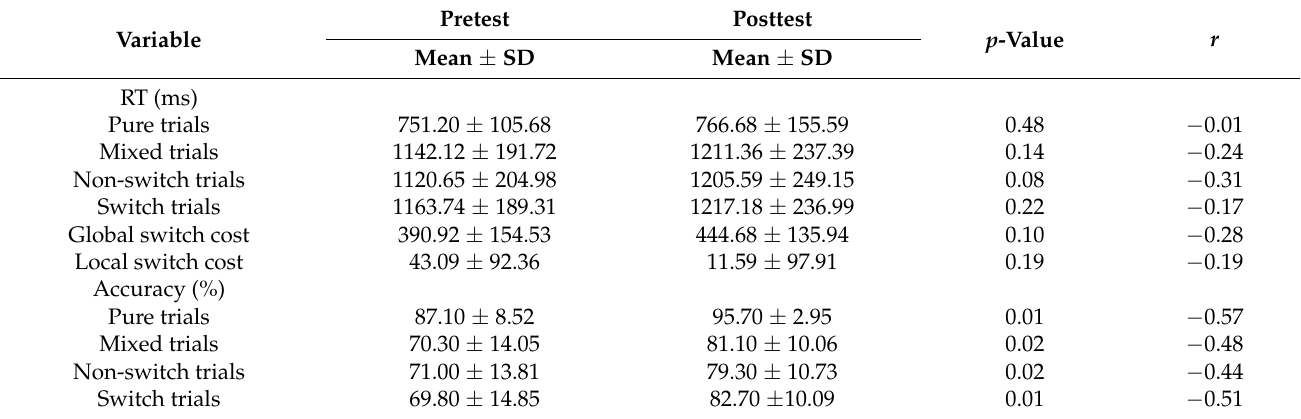
Table 3. Switching Task Reaction Times and